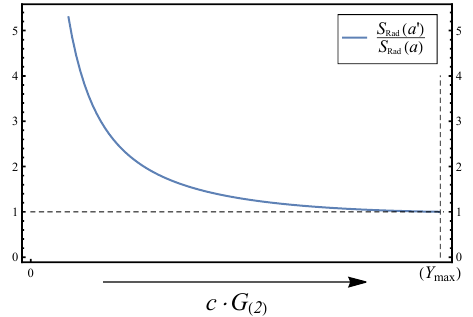
and a 0 represents the root near r . h b